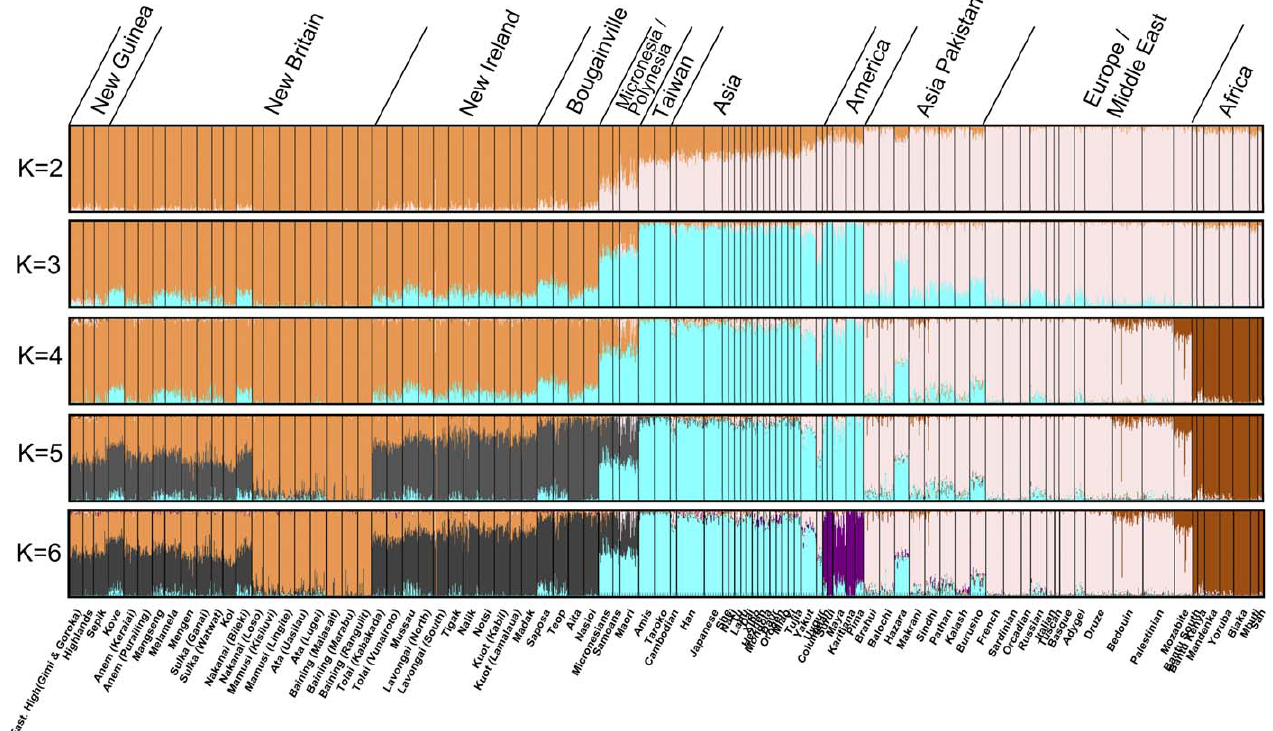
Figure 4. Global Population